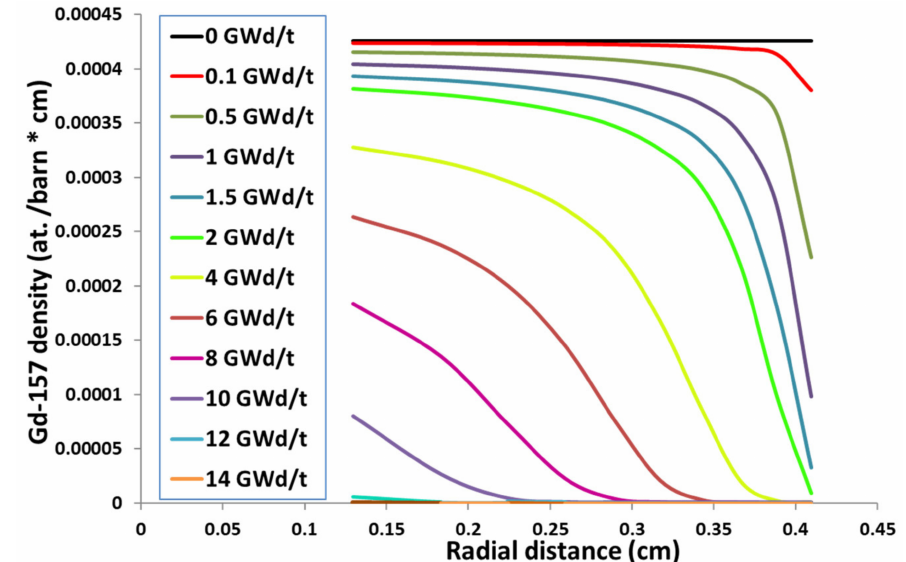
Figure 7. Simulated Gd-157 atomic density of the 3.2 wt% fuel pin at di ff erent burnup levels (using 10 annular rings in Serpent). Relatively slow burning down of the inner zones at beginning of life (BOL) is